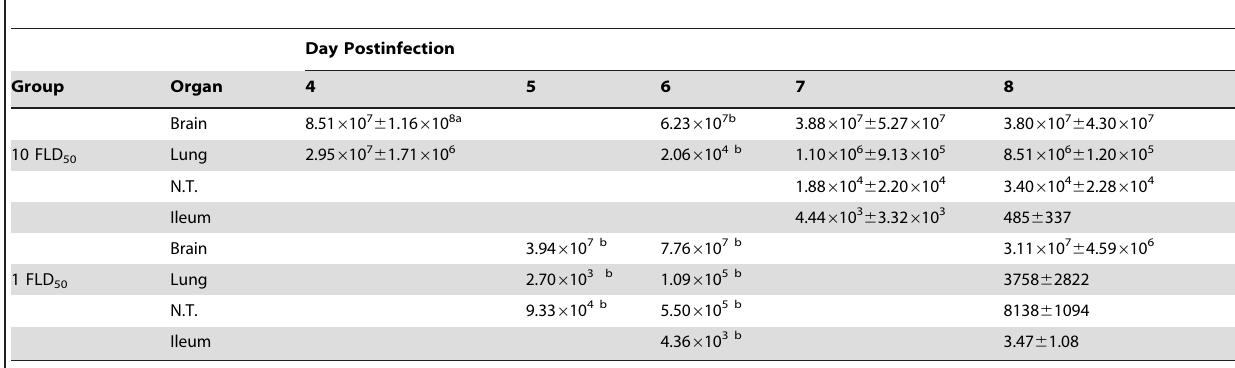
Table 2. Viral load using TaqMan RT-PCR in ferrets infected with virus, A/VN/1203/04 (fg, mean 6 SD).